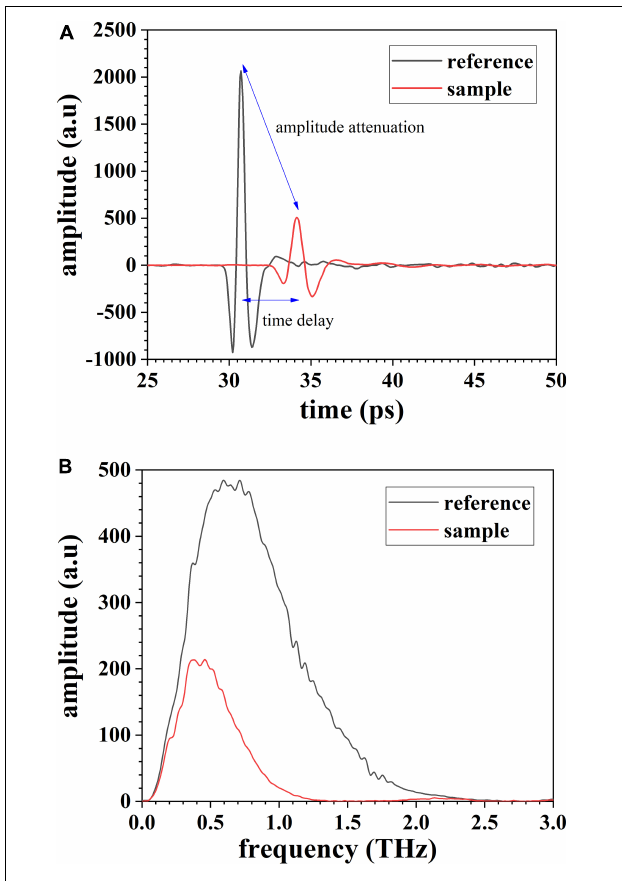
FIGURE 3 | Typical terahertz spectrum of gelatin: (A) signal in time domain and (B) signal in frequency domain.